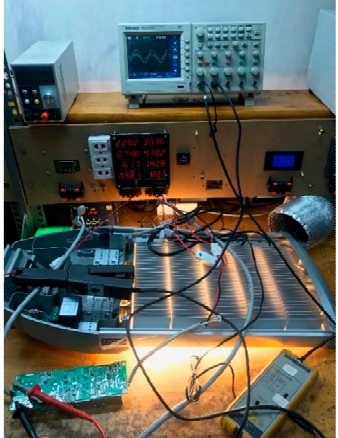
Figure 15. Experimental setup of 150 W LED driver.